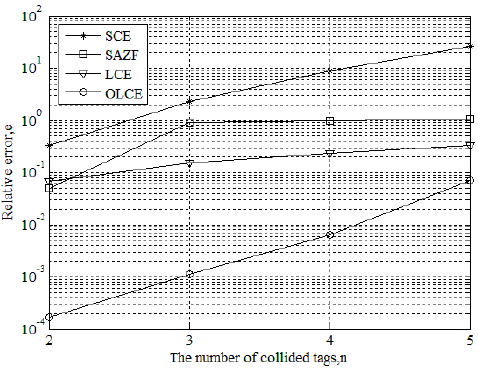
Figure 5. Relative error of channel estimation for SCE, SAZE, LCE, and OLCE when SNR is 16 dB and the number of collided tags ranges from two to five.